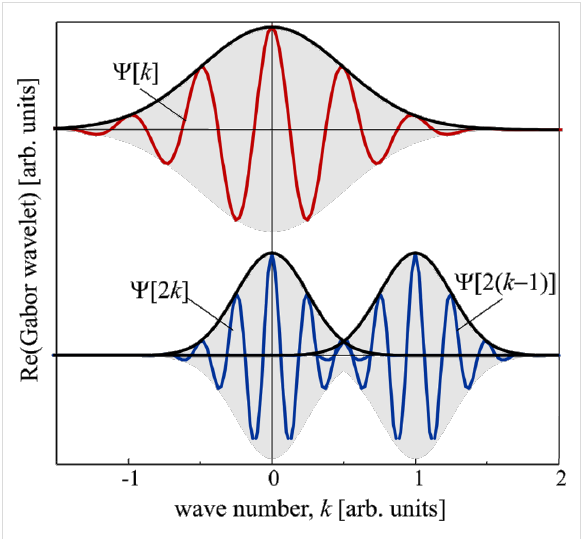
Figure 3: Real part of a Gabor mother wavelet (red curve) and baby wavelets generated by scaling and shifting (blue curves).